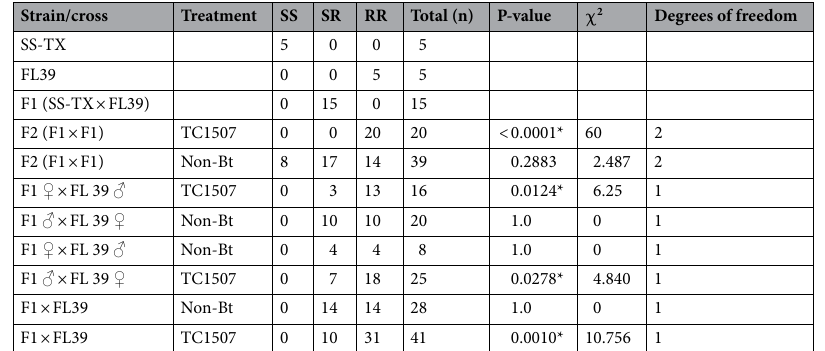
Table 1. Cross and backcross F2 linkage tests for resistance to corn producing Cry1F (event TC1507) and the SfABCC2FL1R allele. The table presents the frequency of S (wild type SfABCC2 ) and r ( SfABCC2FL1R ) alleles in Cry1Fa susceptible (SS-TX) and resistant (FL39) strains of S. frugiperda and in F1 and F2 progenies from their crosses and backcrosses to the FL39 strain. *Statistically significant difference when comparing observed and expected distribution of genotypes based on Mendelian transmission of a single recessive